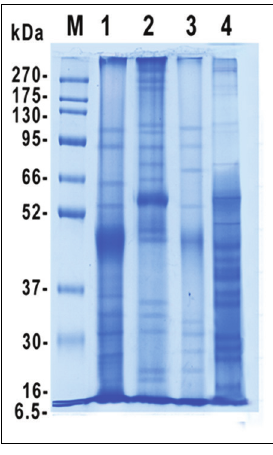
Figure-1: Electrophoretic protein profile of excretory- secretory Cyathostomins spp . antigen (Lane 1), excretory- secretory Strongylus vulgaris antigen (Lane 2), crude somatic Cyathostomins spp. antigen (Lane 3), crude somatic S. vulgaris antigen (Lane 4), and BLUltra pre- stained protein ladder, genedirex (Lane M, 6.5-270 kDa).